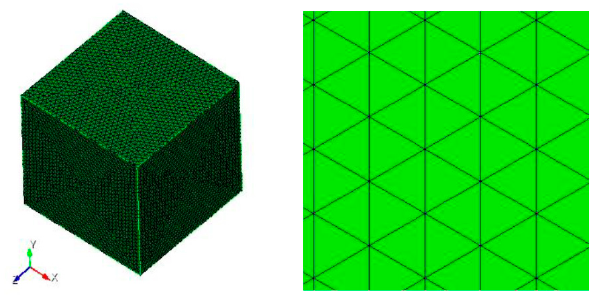
Figure 2. PEC cube model.